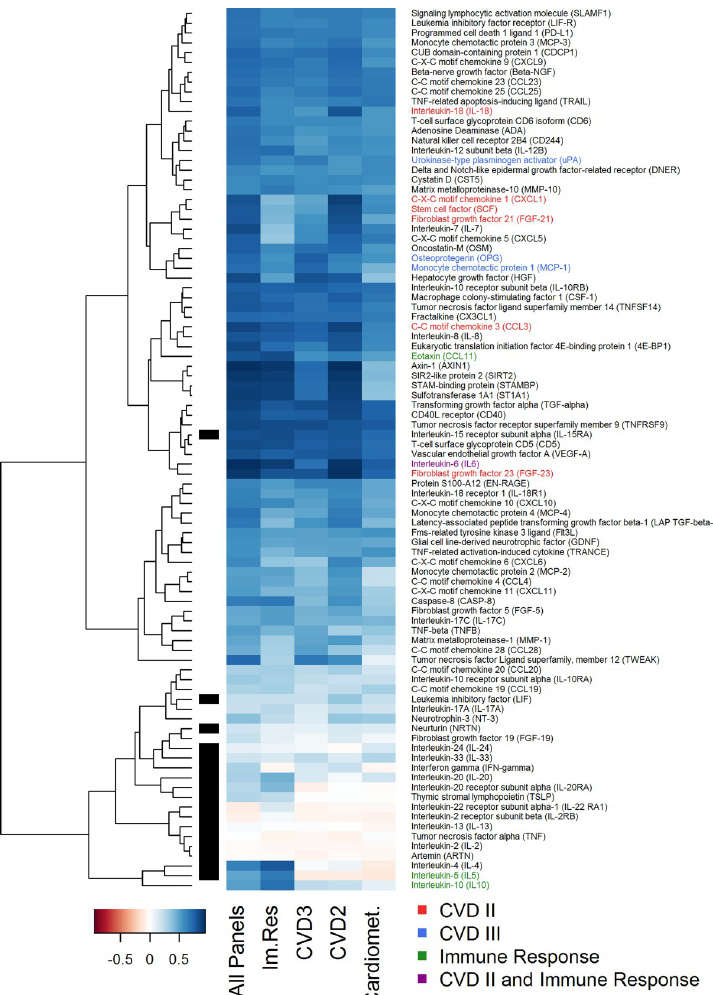
Fig 3. Imputation accuracy depends on utilized protein panels. Pearson correlations between imputed (missForest) versus remeasured values for 91 proteins, comparing the use of different protein panels for imputation (all 5 panels versus Inflammation and one additional panel). Black bars mark proteins with more than 25% of values below LOD. Colored protein names mark proteins with duplicate measurement (red: CVD II and Inflammation; blue: CVD III and Inflammation; green: Immune Response (Im. Res) and Inflammation) or triplicate measurement (violet: CVD II, Immune Response, and Inflammation). Im. Res: Immune Response.